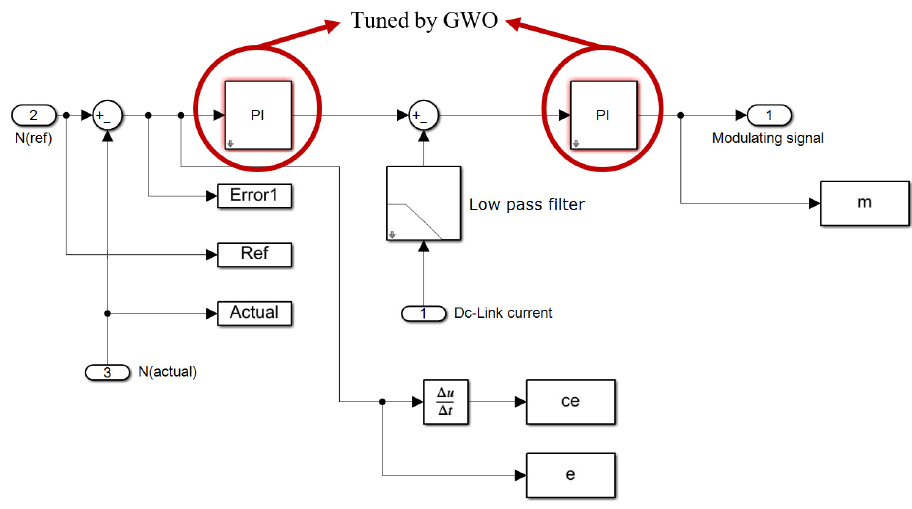
Figure 8. Simulink model for H-GWO-PI controller.